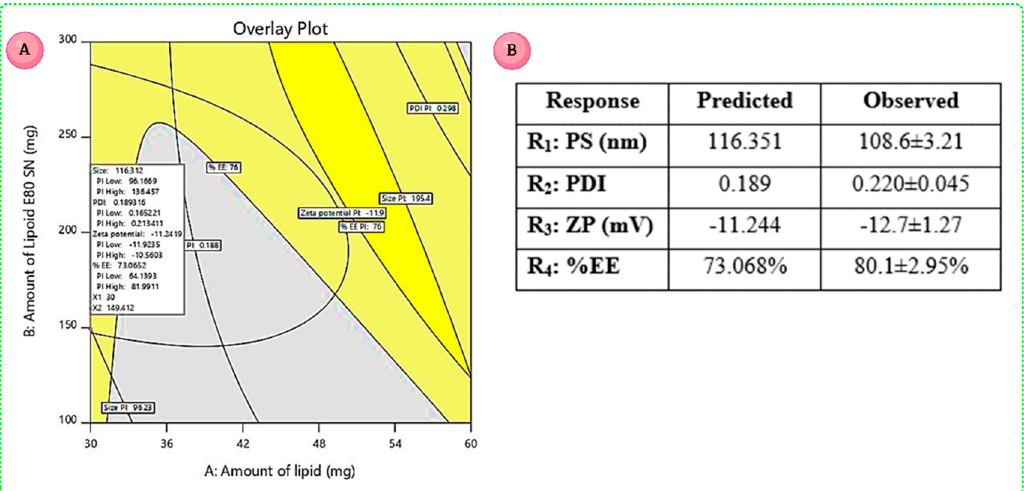
Figure 4. ( A ) Overlay plot representing area of optimized formula for XH-SLNs. ( B ) Predicted and observed values of the optimized batch of XH-SLNs.